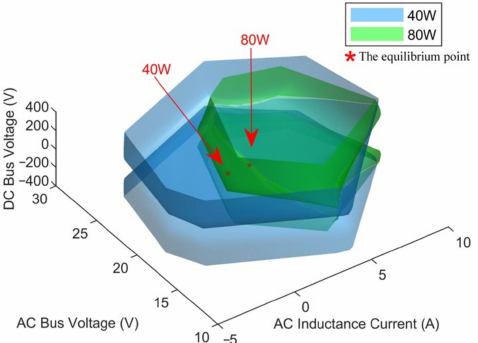
Figure 14. The 3D RAS of microgrids with the battery in discharging mode (CPL power is 40 W and 80